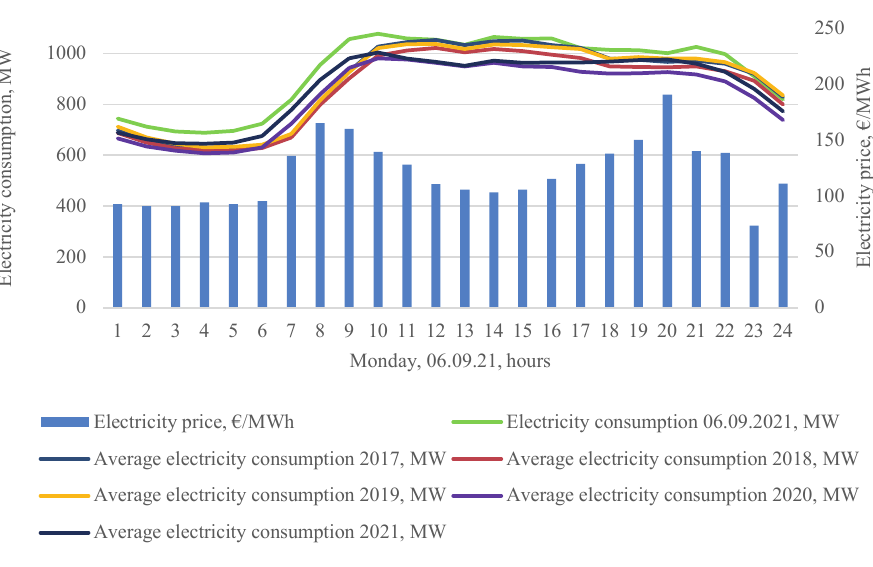
Fig. 9. The comparison of high – cost electricity